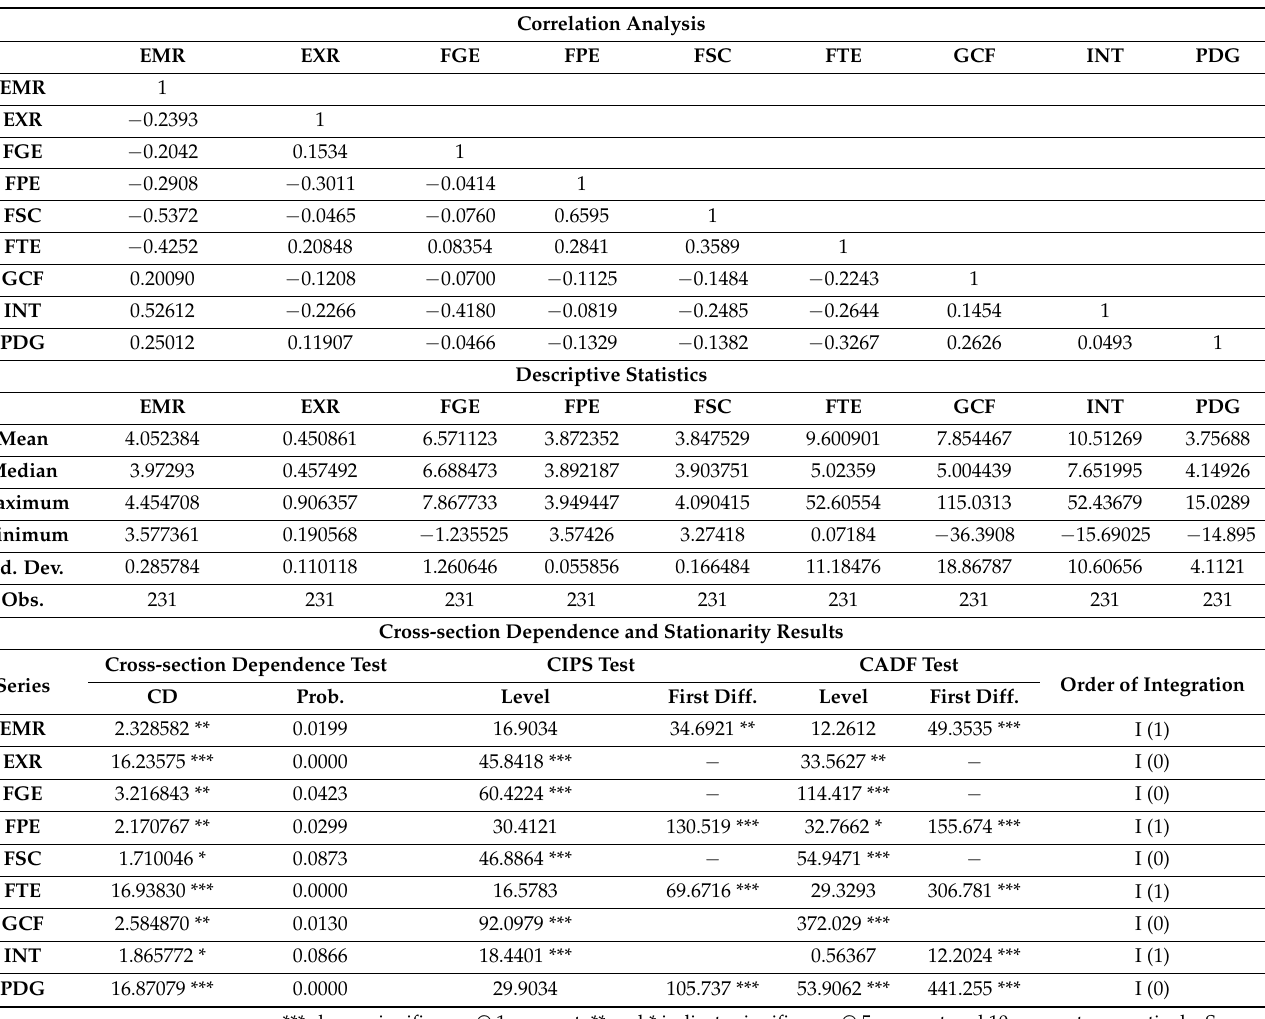
Table 2. Preliminary Analysis